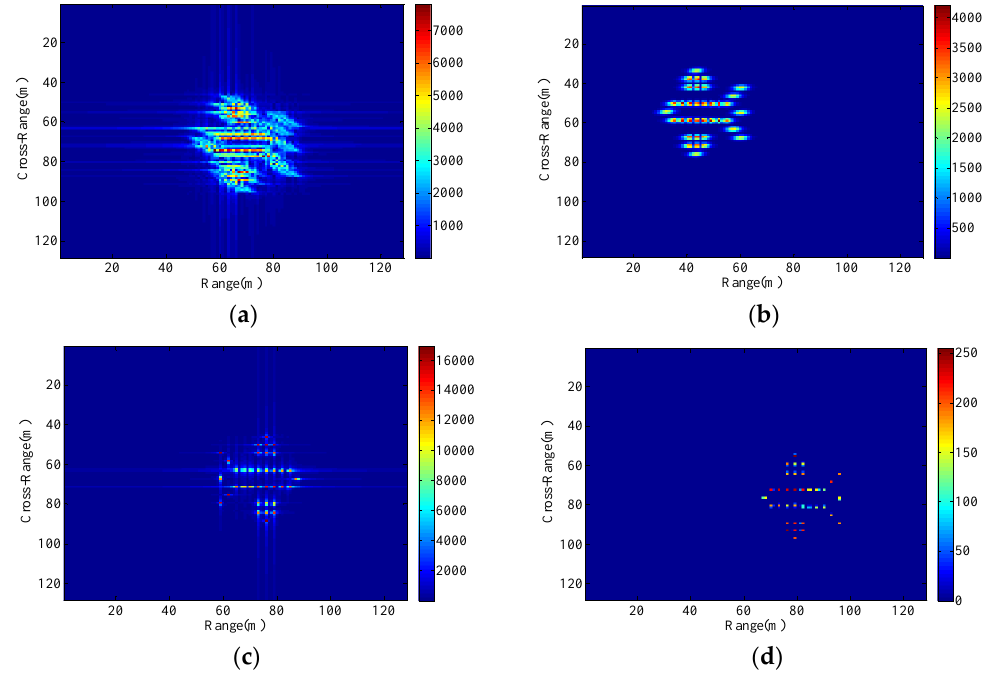
Figure 7. Imaging results with the radar platform displacement parameters P3. ( a ) RD algorithm; ( b ) cross-correlation method; ( c ) minimum entropy method; ( d ) the proposed method.